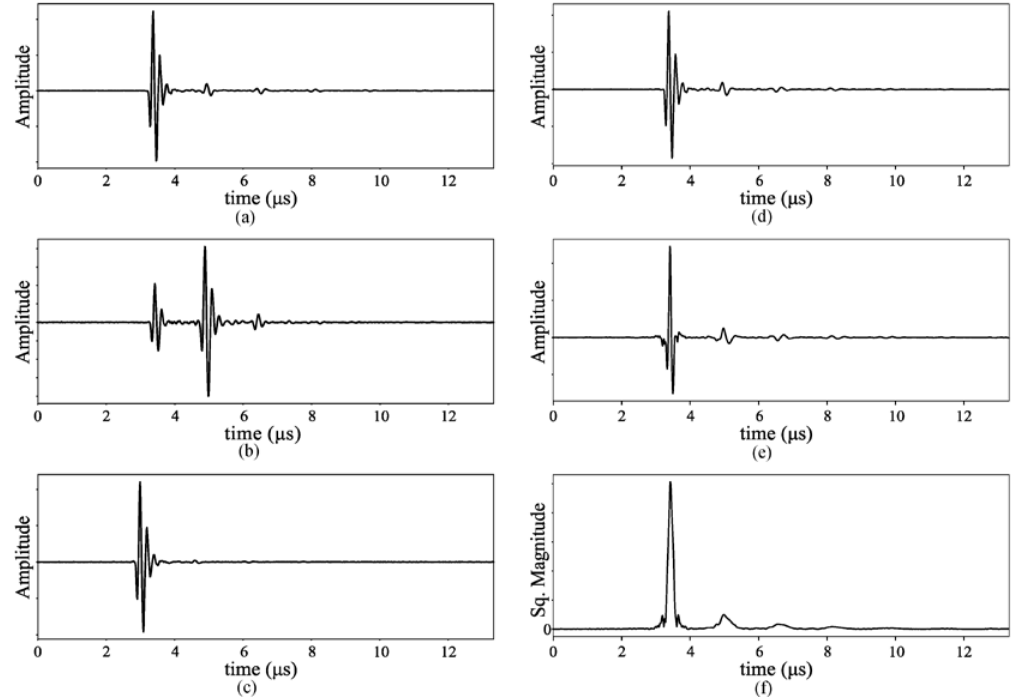
Figure 6. Examples of A-scans for different interfaces: ( a ) copper–copper, ( b ) PLA-copper and ( c ) copper–PLA. ( d ) Unprocessed A-scan, ( e ) compressed A-scan after Wiener filter and ( f ) its envelope.